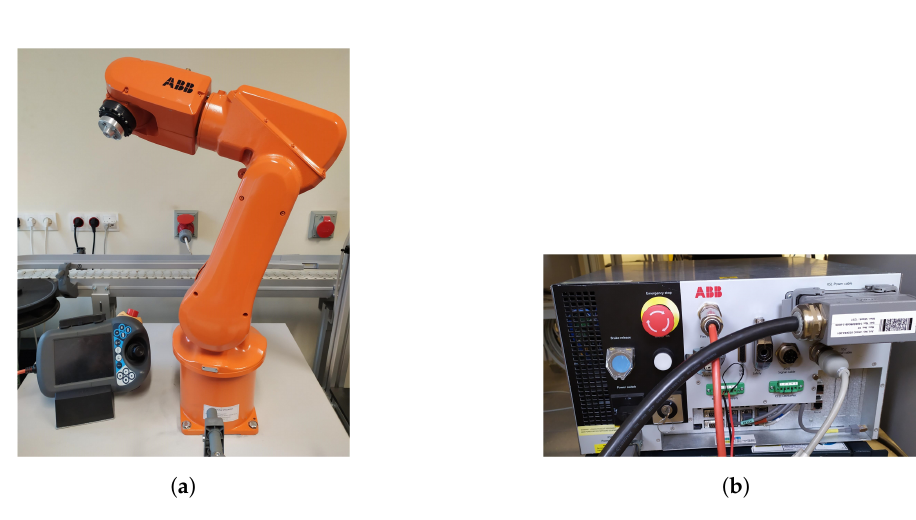
Figure 1. General view: ( a ) ABB IRB 120 robot with FlexPendant; ( b ) IRC5 Compact robot